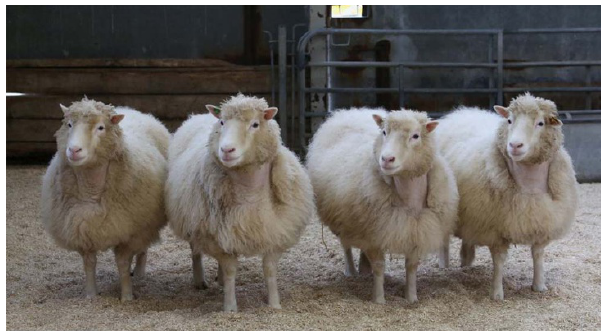
Figure 1 | Four 8-year old Finn-Dorset clones born in July 2007 and derived from the mammary-gland cell line that gave rise to